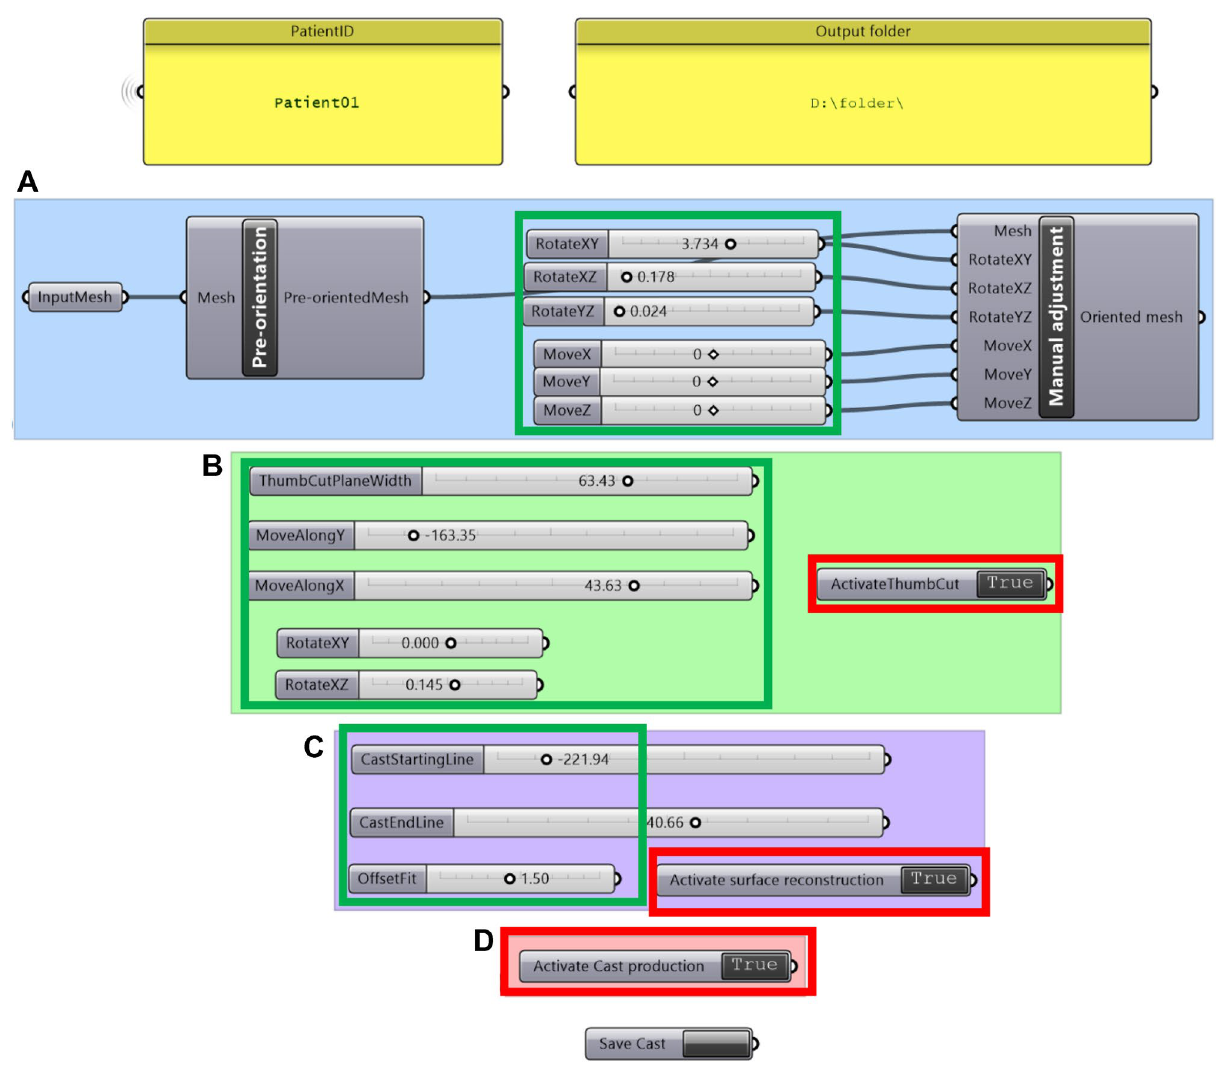
Fig. 3 Grasshopper® User Interface. Blocks refers from a to d to Fig. 1B; Number Slider in green boxes, Toggle switch in red